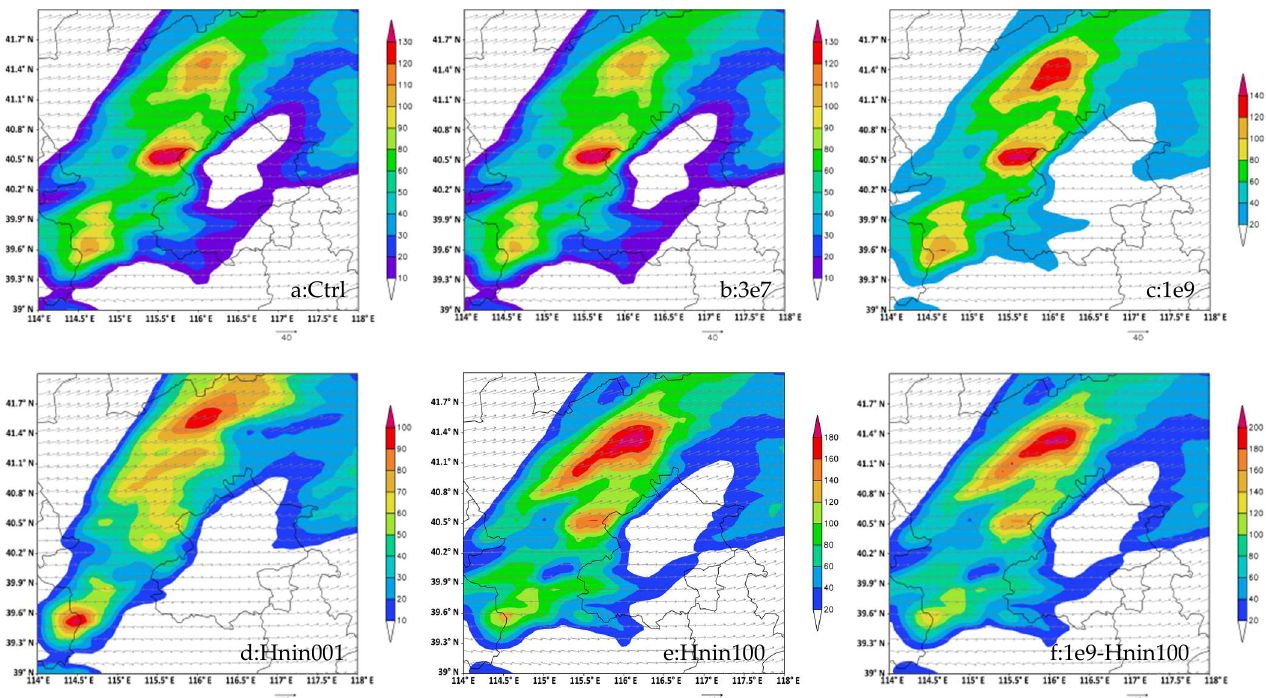
Figure 6. Horizontal distribution of total number concentration of precipitation particles of the control and five sensitivity simulations at a height of approximately 5 km (L − 1 ) on 17 March, 11 UTC, 2012.